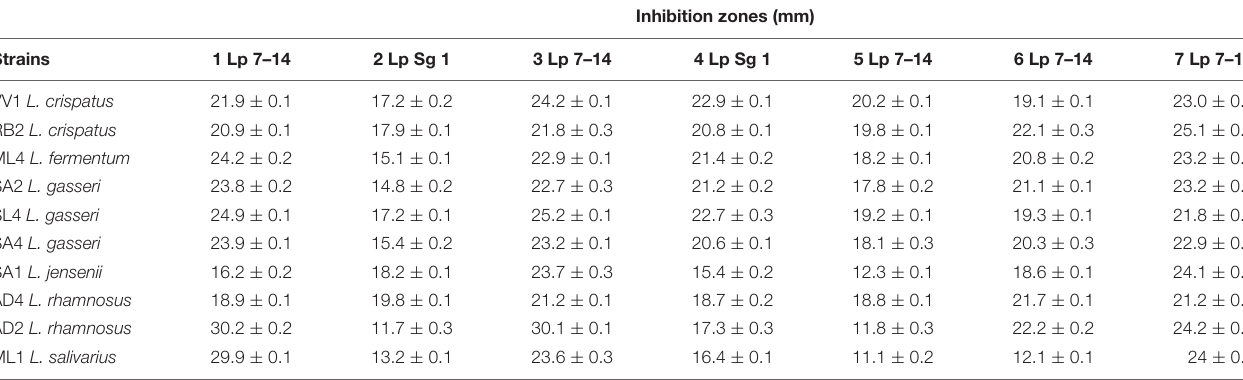
Inhibition zones (mm)